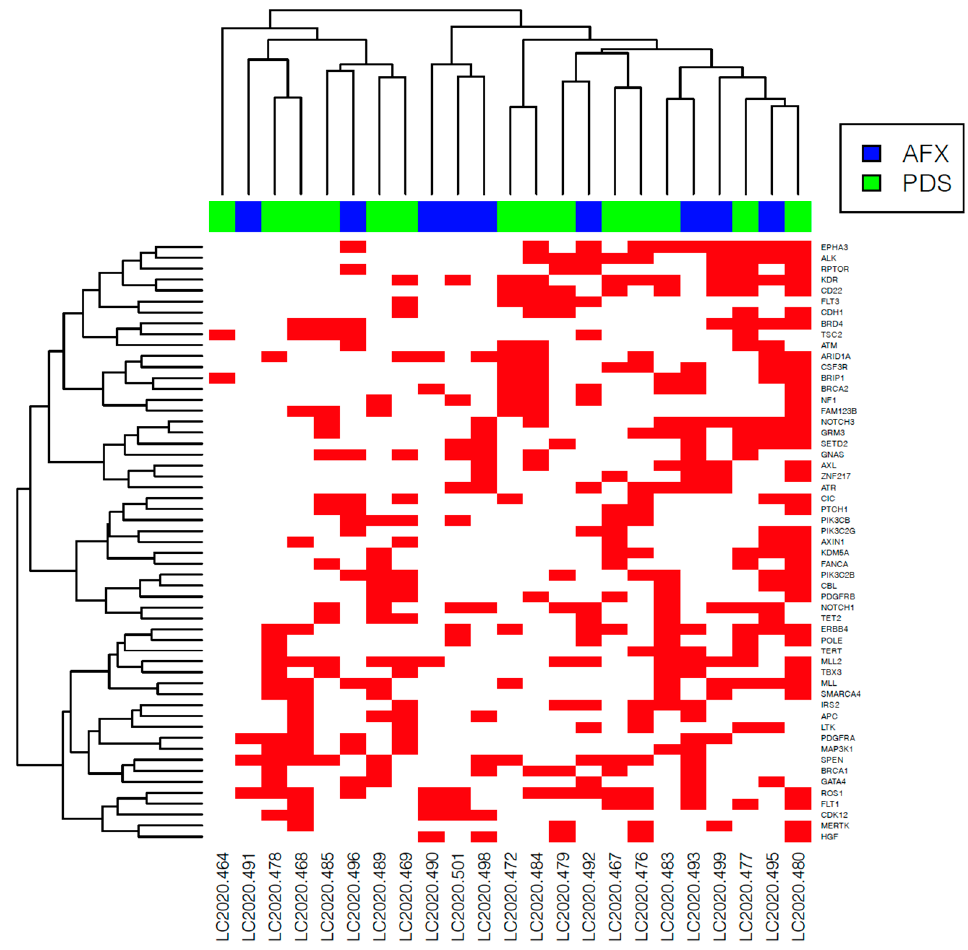
Figure 7. Lollipop plots highlighting genomic alterations of unknown mutations in selected genes: ( a ) GATA4A (GATA binding protein 4) and ( b ) CDH1 (cadherin 1) in AFX and PDS. Blue circles are indicating truncating mutations. The height of the line represents the number of mutations at the specified position. The grey bar represents the entire protein with the different amino acid positions (aa). The coloured boxes are specific functional domains.